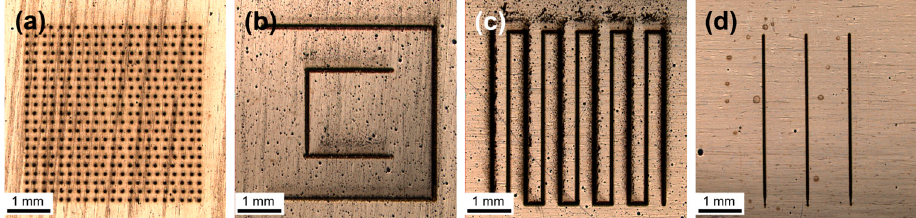
Figure 1. Different shapes created by DLW on the Ni/Al RMF. ( a ) Single hole, ( b ) double C, and ( c ) comb, all cut at 100 fs and 1 kHz; ( d ) single lines, cut at 150 fs and 1 kHz. The area structured is 16 mm 2 for all samples, and all lines and holes penetrated through the 40 µ m thickness of the foil.